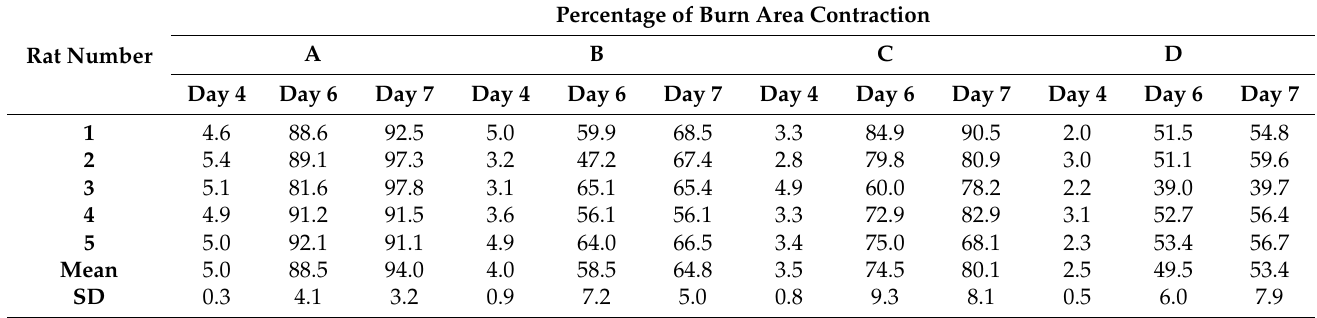
Table 3. Percentage of burn area contraction after treatment with TTO-loaded nanolipogel (area A),